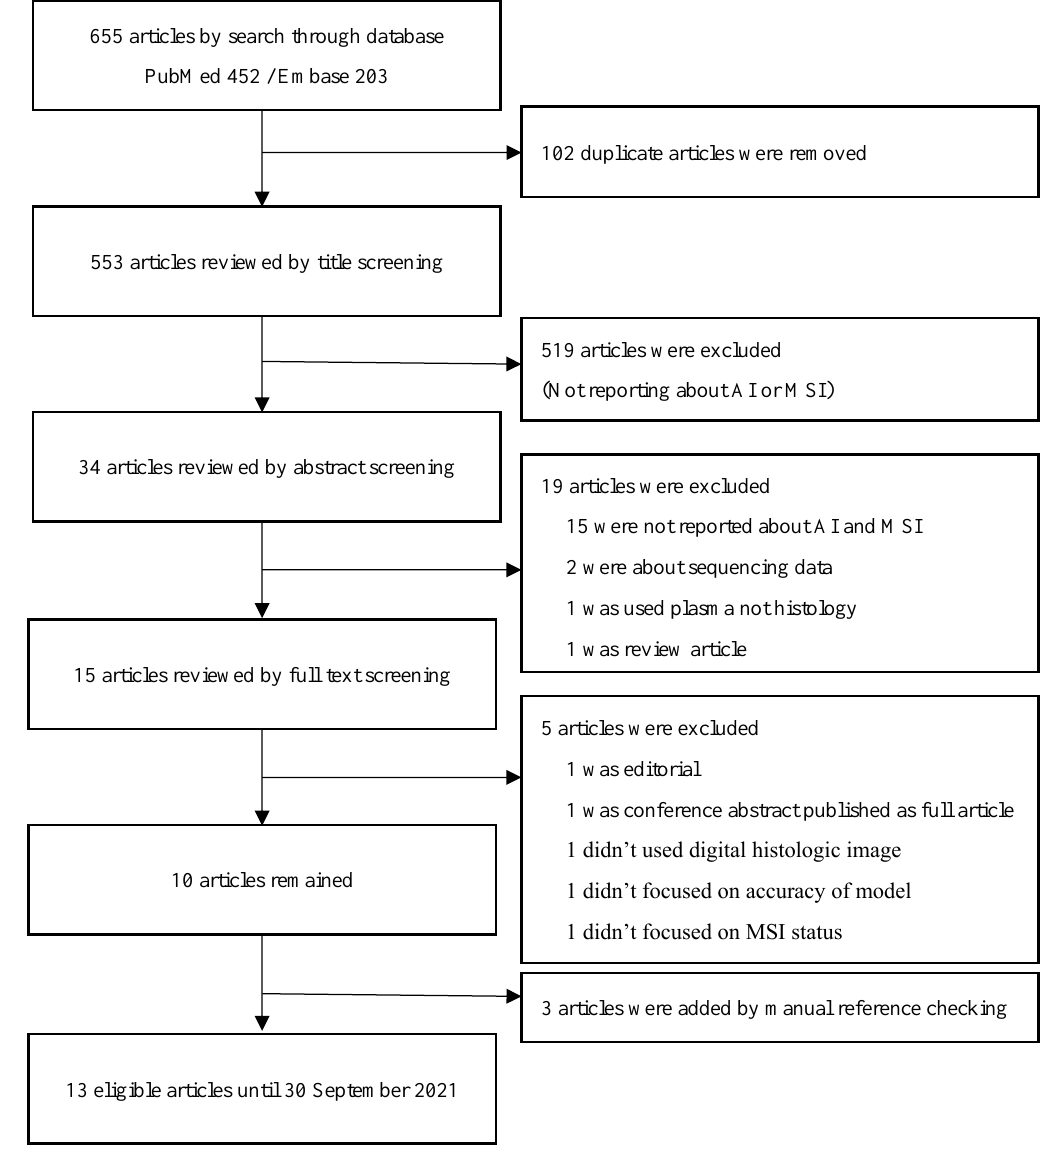
Figure 2. Flow chart of literature search.